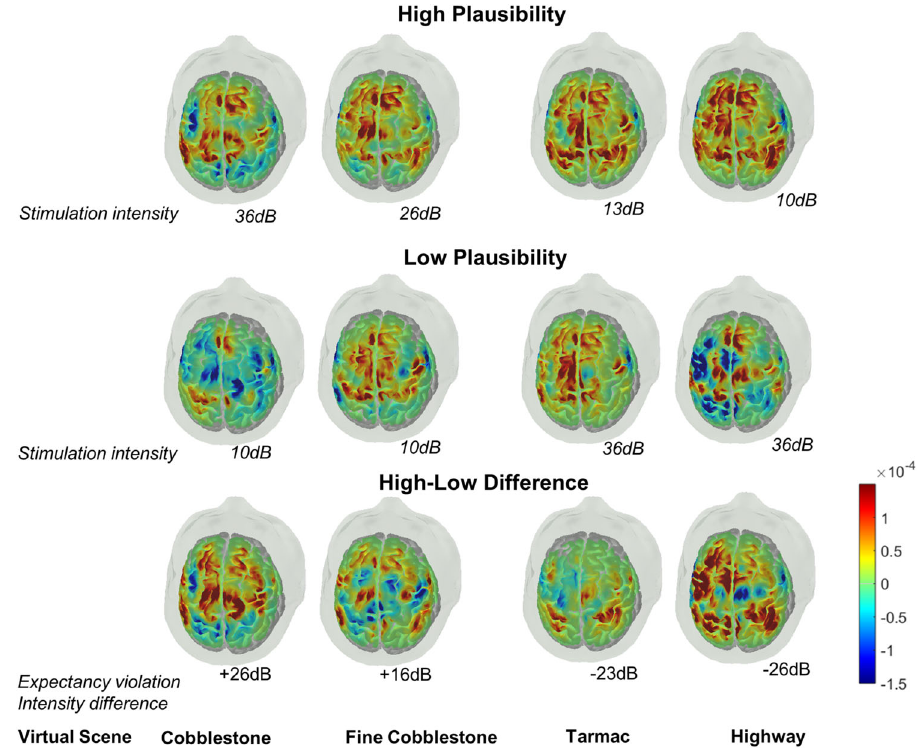
Fig. 2 Topographical plots of levels of HbO concentration across all channels. The different columns correspond to the four different road scenes. The top and middle rows show results, respectively, from scenarios with vibrotactile stimulations at intensity levels of higher and low plausibility. The third row shows contrast plots (high – low plausibility).